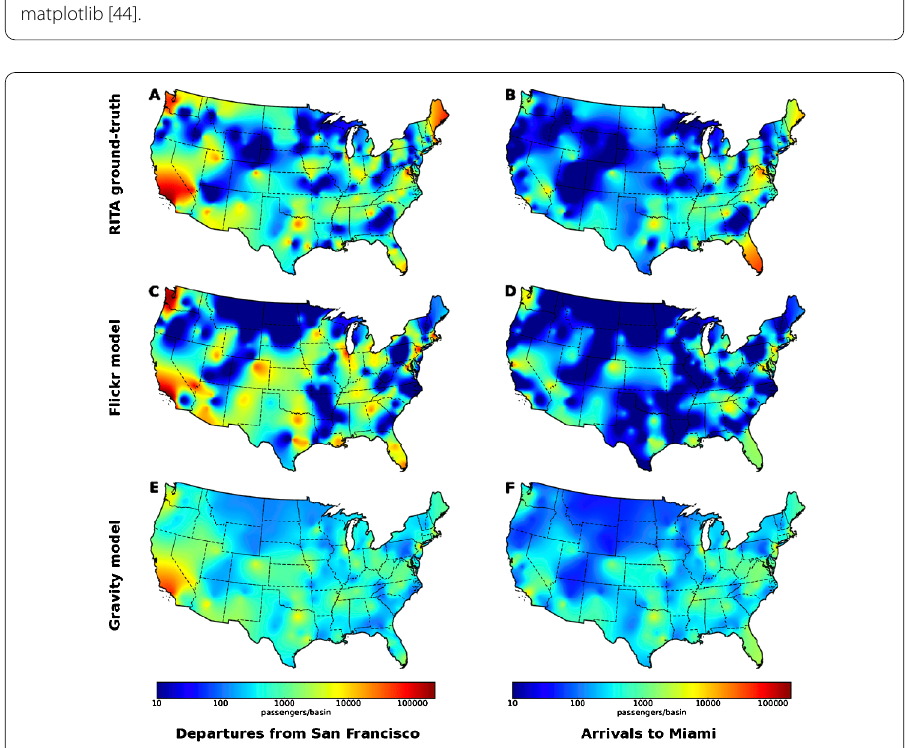
Figure 3 Departures and arrivals in the air transportation network. Heatmaps representing the distribution of predicted and real trips (A) , (C) , (E) departing from San Francisco towards other airport basins and (B) , (D) , (F) arriving to Miami from other airport basins in the Continental US. (A), (B): Ground-truth trips from the RITA air travel dataset. (C), (D): Flickr model. (E), (F): Gravity model. Visualization created with matplotlib